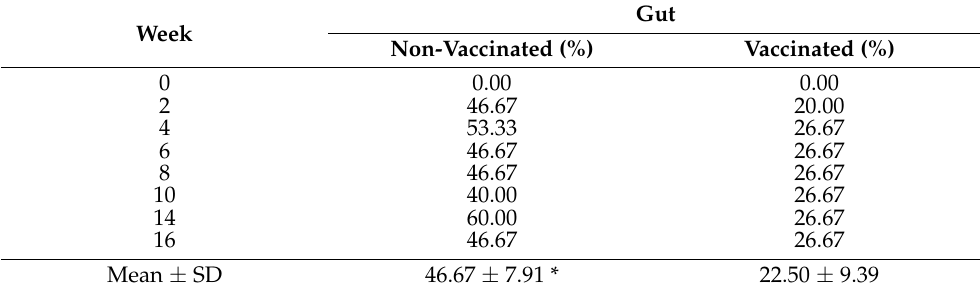
Table 2. Rate of Vibrio spp. isolation (%) in the gut of Asian seabass. Asterisks (*) indicate a significant difference at p < 0.05 between the vaccinated and non-vaccinated groups.